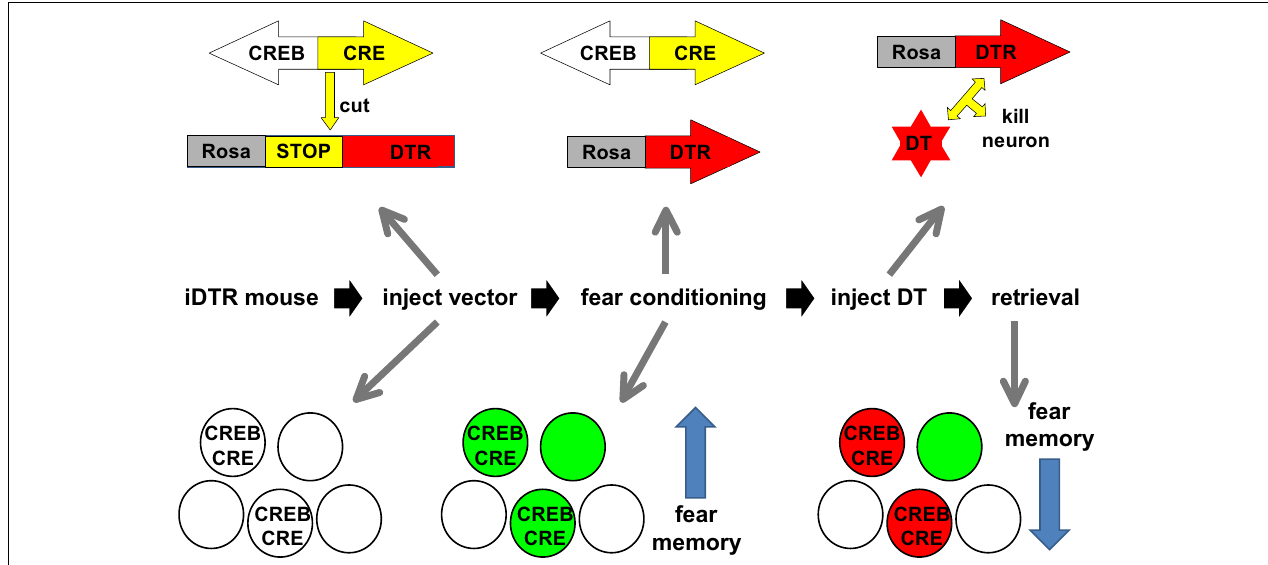
The mice were then subjected to fear conditioning. An earlier study from the same authors (Han et al., 2007) demonstrated that the CREB expressing neurons participate in the storage of the fear memory (green circles symbolize neurons that participate in the storage of the memory). After fear conditioning, mice were injected with diphtheria toxin (DT), which killed the CREB expressing neurons which participated in the encoding of that memory (red circles). This caused a signifi cant reduction in the strength of the fear memory measured during